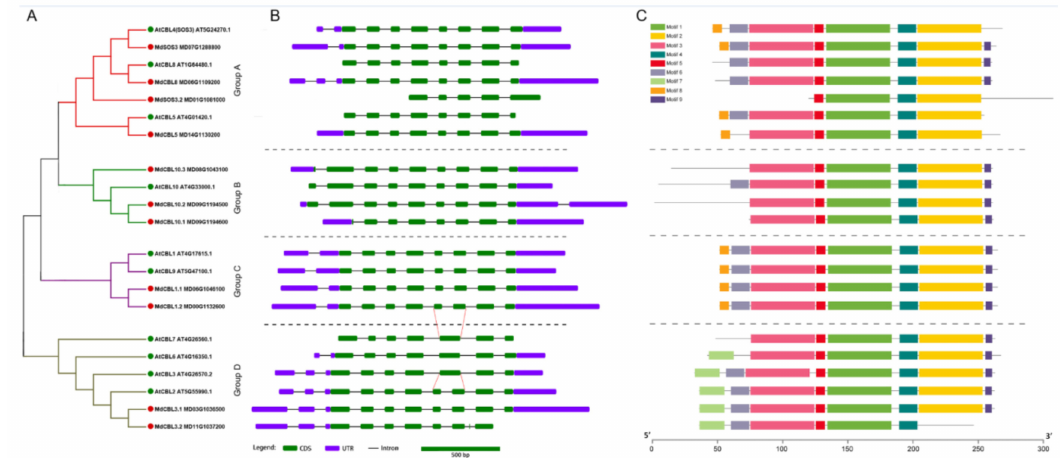
Figure 2. Phylogenic relationships ( A ), gene structure ( B ), and conserved motifs ( C ) for CBL family proteins in apples and Arabidopsis . Green and red dots indicate CBL proteins in Arabidopsis and apple, respectively. Red lines show that the fifth exon of AtCBL7 and AtCBL3 could be further differentiated into two shorter exons. Introns are represented by black line segments of the same length to facilitate the comparison of the exon–intron composition patterns of these